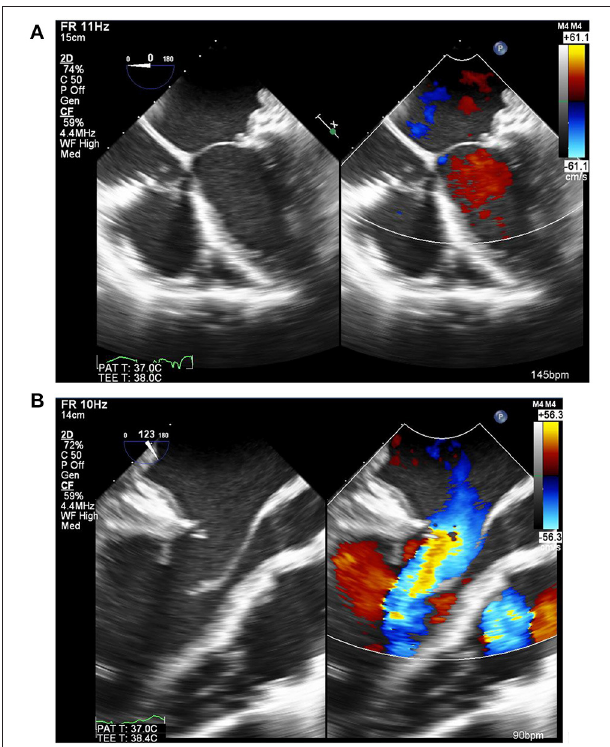
FIGURE 10 | Echocardiogram of the mitral valve after repair by peeling of the anterior leaflet coupled with a pericardial posterior annuloplasty. This showed good coaptation (A) , laminar flow through the valve and excellent mobility of the leaflet (B) [Courtesy of Aswan Heart Center (AHC)